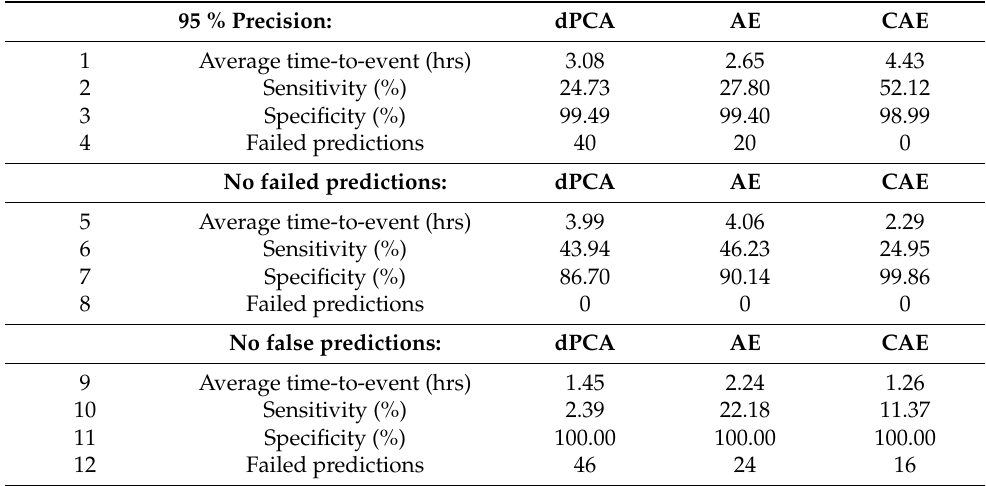
Table 9. Event prediction performance at different prediction thresholds for dPCA, AE, and